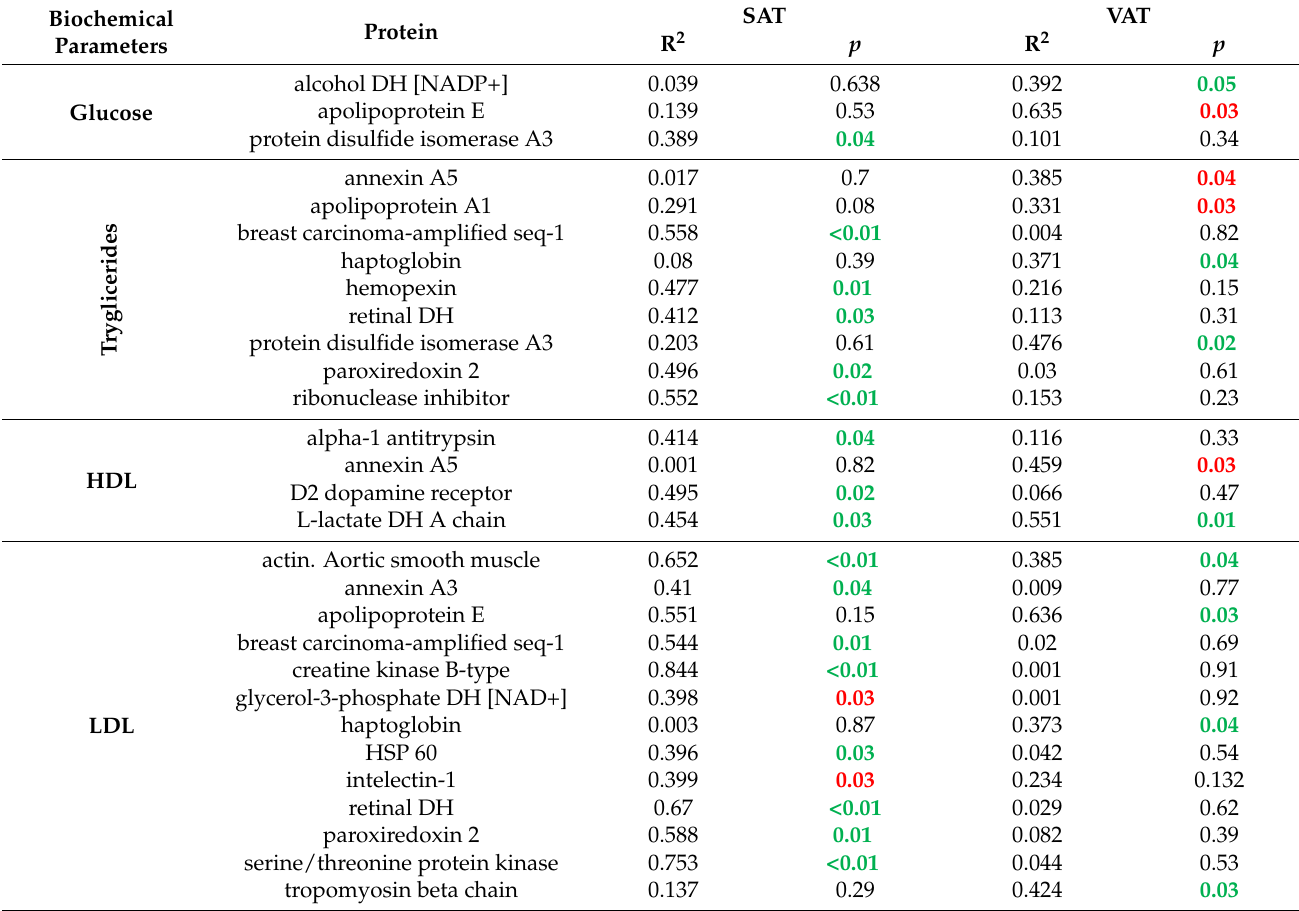
Table 4. Correlation between protein expression and different biochemical parameters. Direct regression in green and inverse regression in